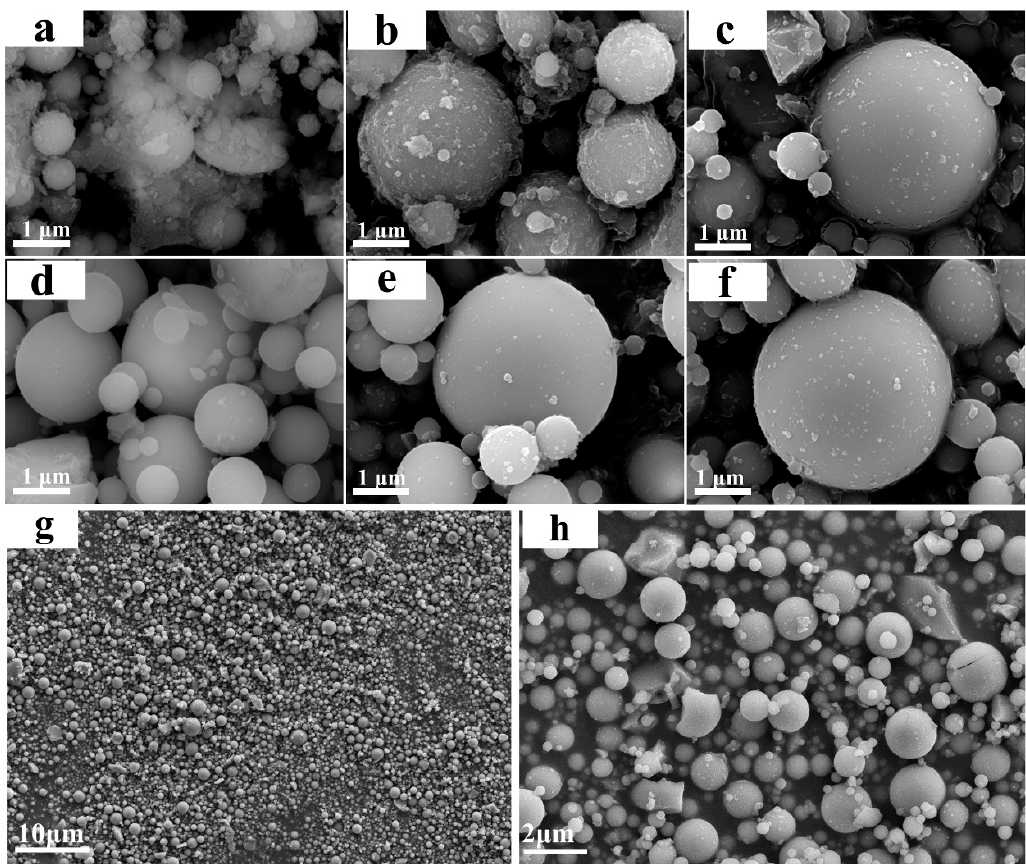
Figure 2. SEM images of ( a ) 0.6-SiO 2 -M-6.5, ( b ) 0.6-SiO 2 -M-7.0, ( c ) 0.6-SiO 2 -M-7.5, ( d ) 0.6-SiO 2 -M-8.0, ( e ) 0.6-SiO 2 -M-8.5, and ( f ) 0.6-SiO 2 -M-9.0, respectively; lower magnification SEM images of 0.6-SiO 2 -M-7.5 ( g , h ). Table 1 listed the quantity of hydroxyl groups on the surface of 0.6-SiO 2 -M-7.5 and